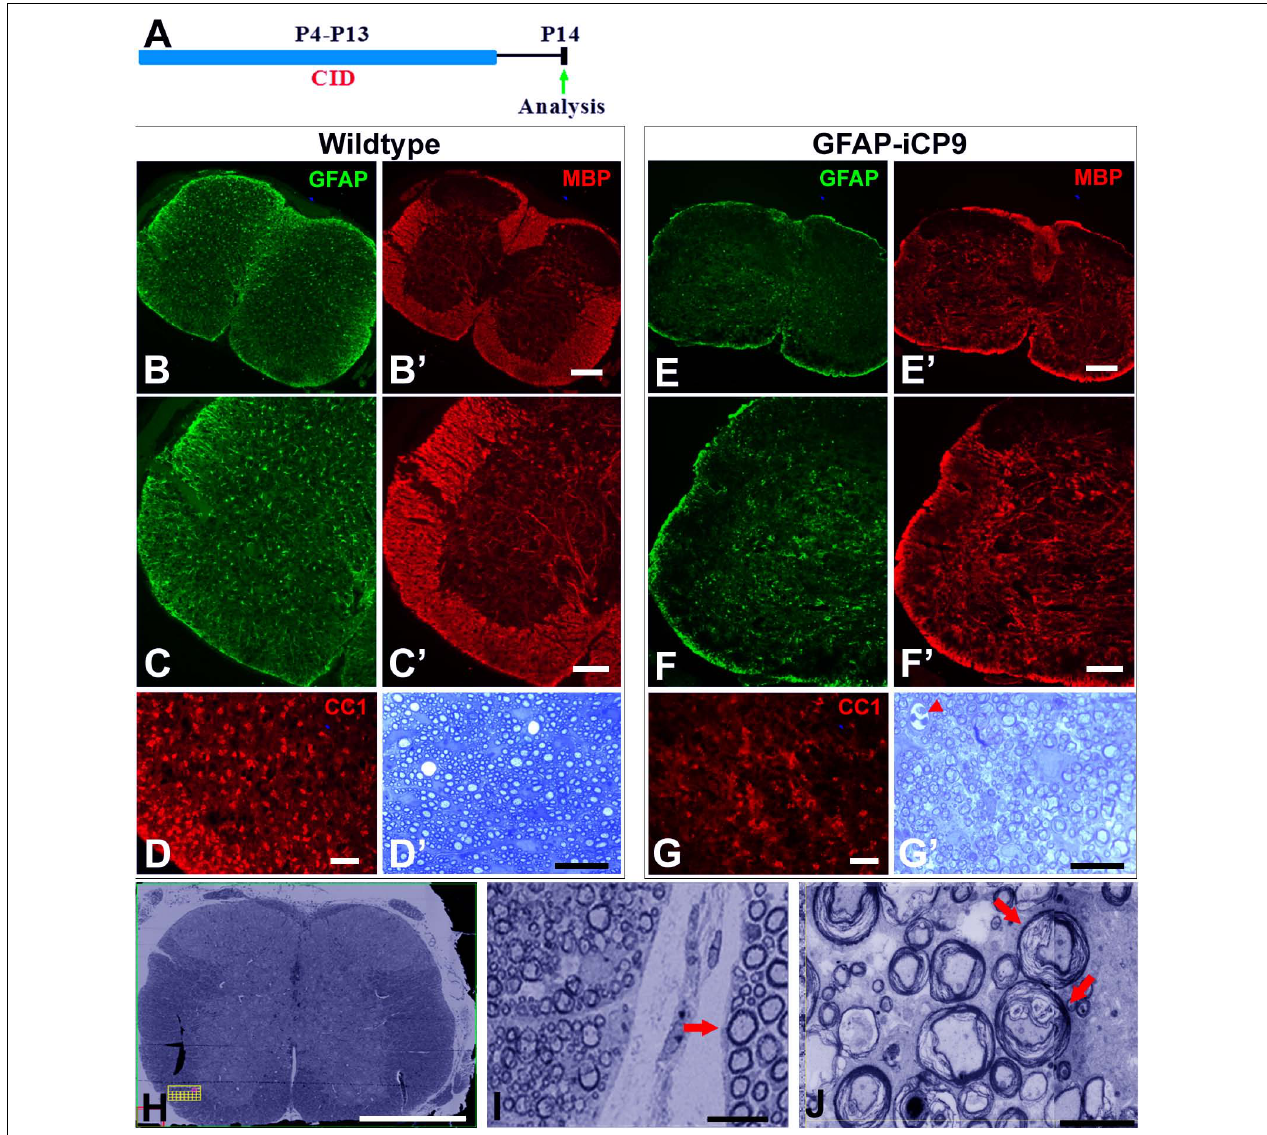
FIGURE 4 | Extended intervals of astrocyte loss compromises myelin integrity. (A) Experimental design. Intrathecal injections of CID were done every other day between P4 and P13 and animals analyzed on P14. (B–D) In WT spinal cord following CID treatment GFAP+ astrocytes (green) were abundant in gray and white matter (B,C) and MBP expression (red) was normal with intense expression in white matter and significantly lower expression in gray matter (B’,C’) . The density of CC1+ cells (D) and levels of myelination as assessed quantitatively with toluidine blue on 1 µ m sections (D’) were normal. By contrast, in GFAP-iCP9 spinal cords following CID treatment GFAP+ astrocytes (E,F) and levels of MBP expression (E’,F’) were significantly reduced in white matter such that there was no obvious distinction between expression in white and gray matter. (G) The relative number of CC1+ cells was reduced in white matter of CID treated GFAP-iCP9 spinal cords (G) compared to WT controls, and myelin appeared disrupted (G’) . (H,I) In GFAP-iCP9 spinal cords CID injection resulted in disruption of myelin integrity and decompaction. (H) Low magnification FIBSEM image confirms lack of contrast between gray and white matter in CID treated segments. (I) The decompaction of